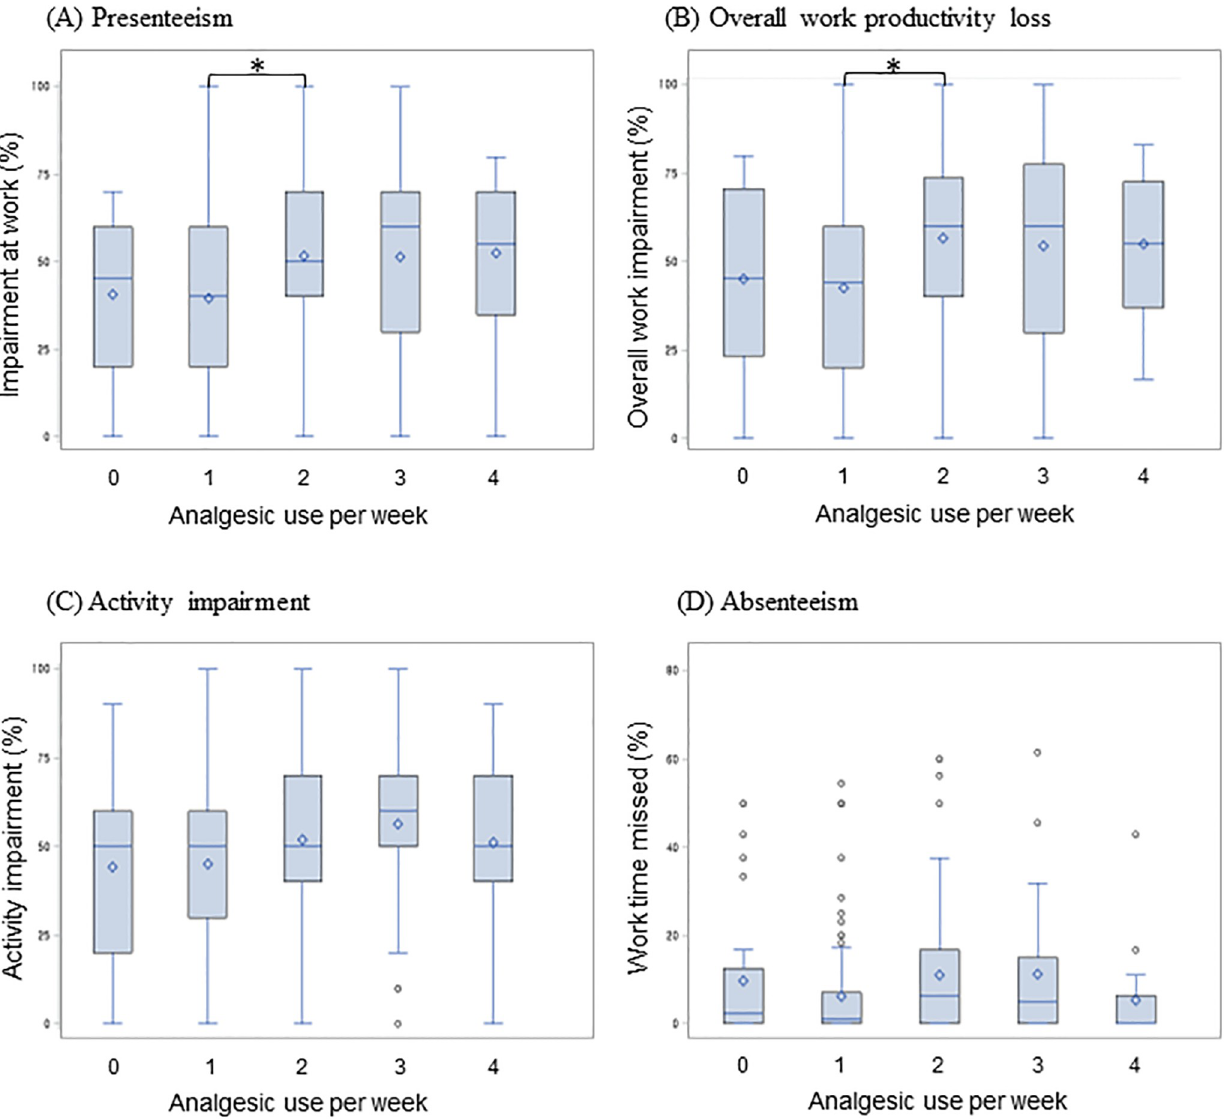
Fig 3. The impact of frequency of analgesic use on Work Productivity and Activity Impairment during previous 1-week. (A) Presenteeism (N = 265) (B) Overall work productivity loss (N = 265) (C) Activity impairment (N = 362) (D) Absenteeism (N = 265) � p <